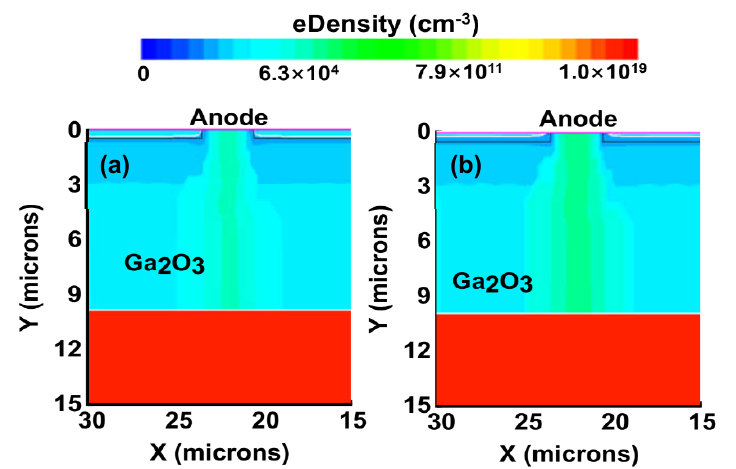
Figure 13. Electron density in HJBS diode with the 8- µ m-width of p-NiO fin, 3- µ m-width of Ga 2 O 3 space at a reverse bias of − 1500 V and p-NiO doping concentration of ( a ) 1 × 10 18 cm − 3 and ( b ) 4 × 10 17 cm − 3 .